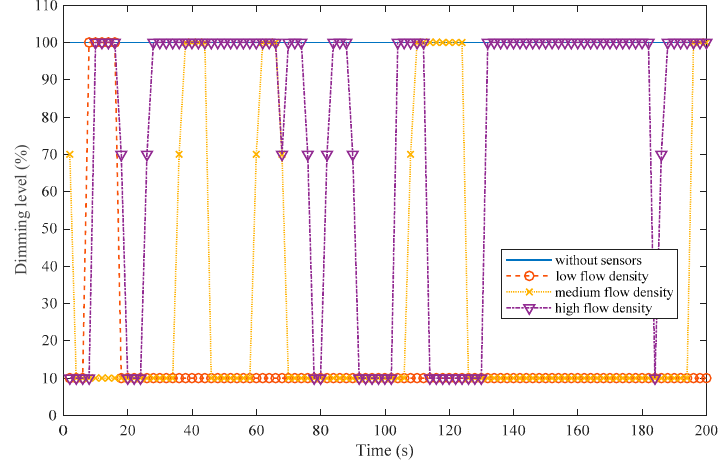
Figure 11. Comparison of dimming levels of a luminaire.